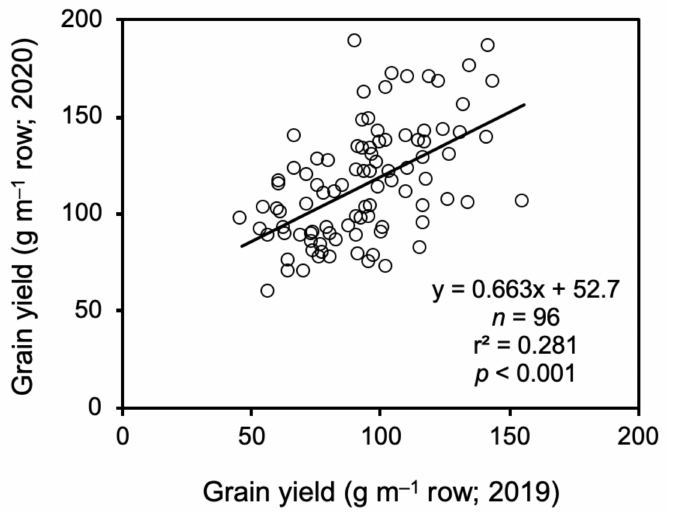
Figure 2. Correlation between grain yield data in 2019 and 2020. There were three points per plot. The soil was a Vertic Calcic Calcisol located on Merredin Research Station ( − 31 ◦ 30 (cid:48) 25 (cid:48)(cid:48) S, 118 ◦ 13 (cid:48) 04 (cid:48)(cid:48)